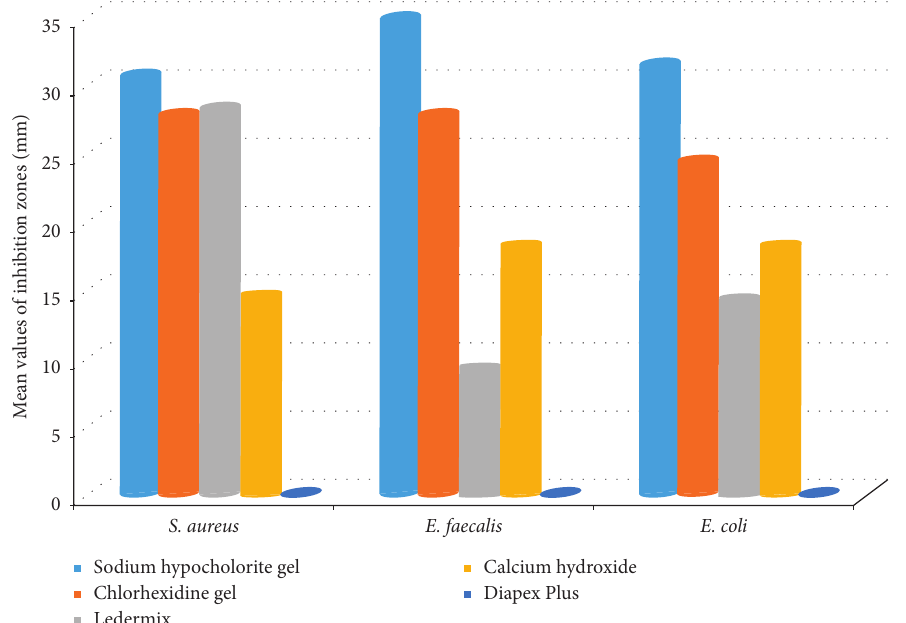
Figure 3: Mean values of the zone diameters of microbial growth inhibition according to the tested medicaments.